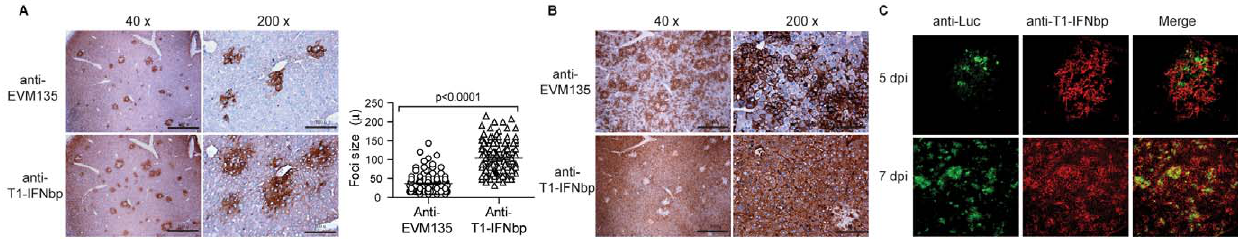
Figure 3. T1-IFNbp binds to infected and uninfected cells in the liver. A ) BALB/c mice were infected with WT ECTV. At 5 dpi livers were harvested and serial sections were stained with anti-T1-IFNbp or anti-EVM135 as indicated. Data are representative of three mice/group and of two independent experiments. The dot plot represents the size of all the foci found in five randomly selected microscopy fields as detected with the two antisera at 5 dpi. B ) As in A, but showing serial sections at 7 dpi. Data are representative of three mice/group and of two independent experiments. C ) As in A and B, but mice were infected with ECTV-Luc and livers sections stained with anti-Luc Ab to identify infected cells (green) and anti-T1- IFNbp (Red). Data are representative of 3 mice and two independent experiments. Original magnification was